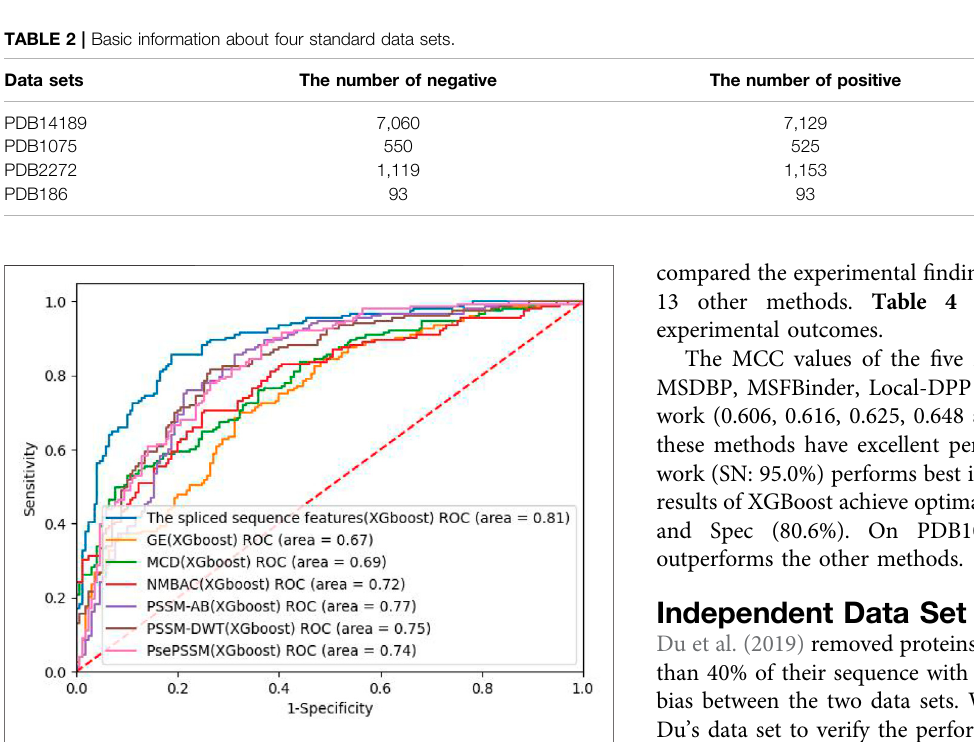
FIGURE 2 | ROC curves of different feature extraction methods on PDB1075